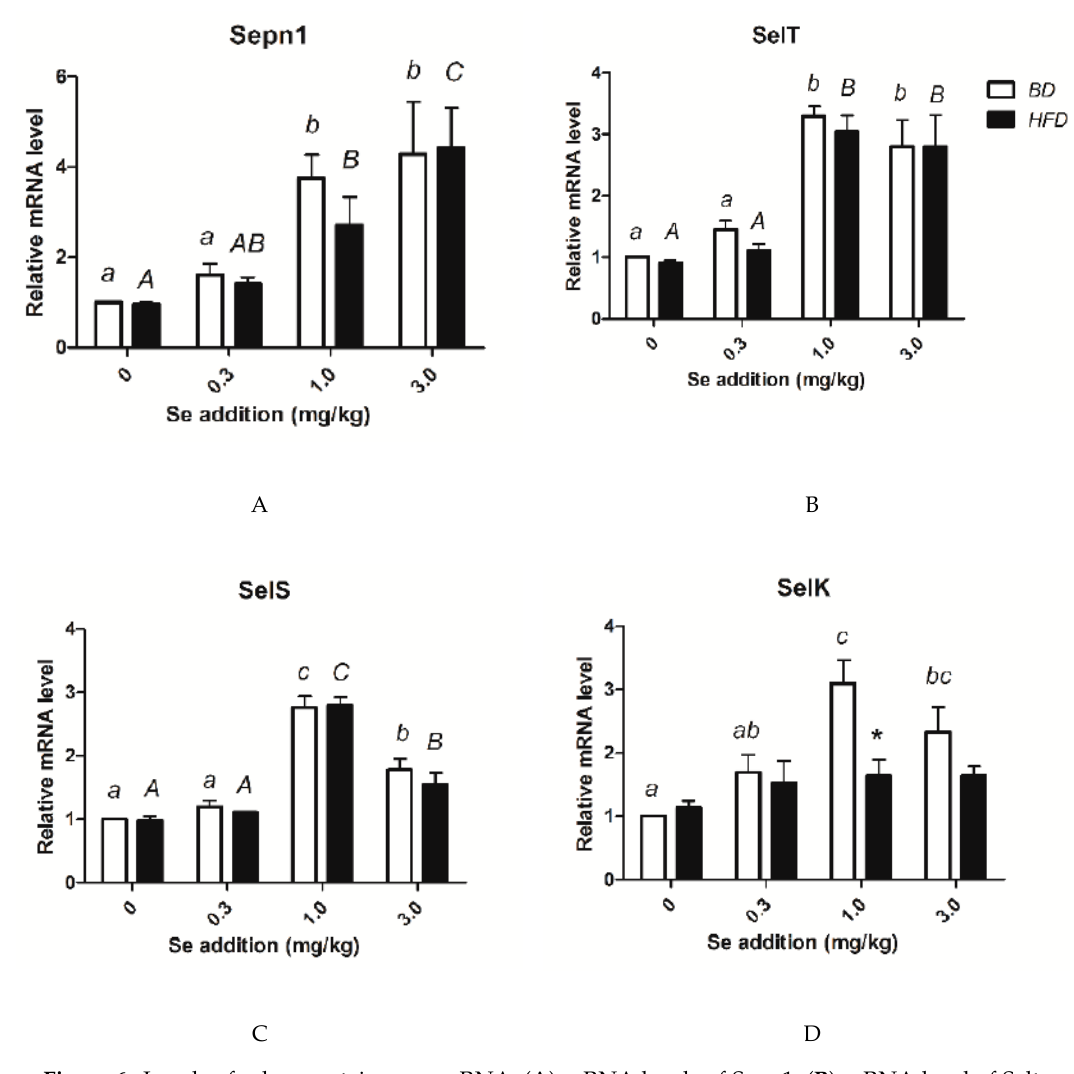
Figure 6. Levels of selenoprotein gene mRNA. ( A ) mRNA levels of Sepn1; ( B ) mRNA level of Selt; Figure 6. ( C ) mRNA level of Sels; ( D ) mRNA level of Selk. * Di ff erent from the BD at that Se addition, p < 0.05. a–c Within BD groups, means without a common letter di ff er, p < 0.05. A–C Within HFD groups, means without a common letter di ff er, p <